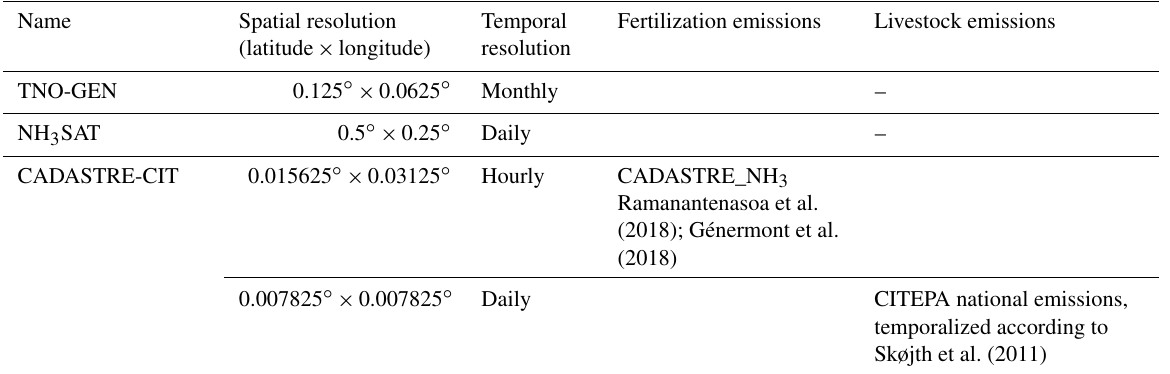
Table 1. Main characteristics of the different compared inventories before their aggregation and disaggregation for the